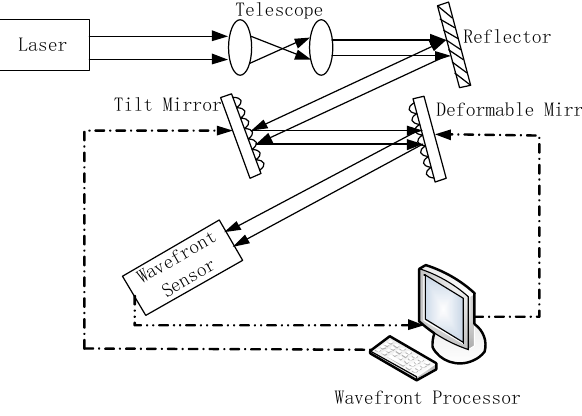
Figure 1. Schematic diagram of adaptive optics.